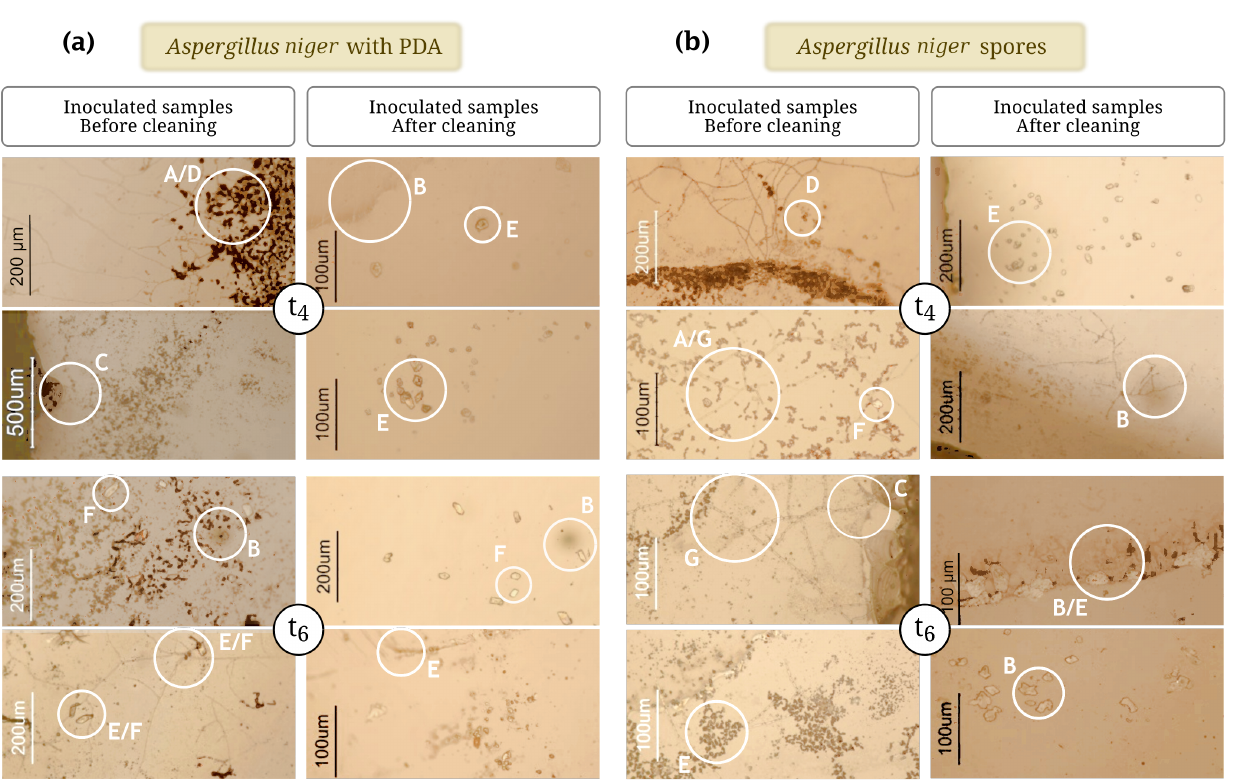
Figure A3. Optical microscopy results from the inoculation of SPB-87 with ( a ) Aspergillus niger in PDA and ( b ) Aspergillus niger spores in Tween solution. Legend as in Figure 2.